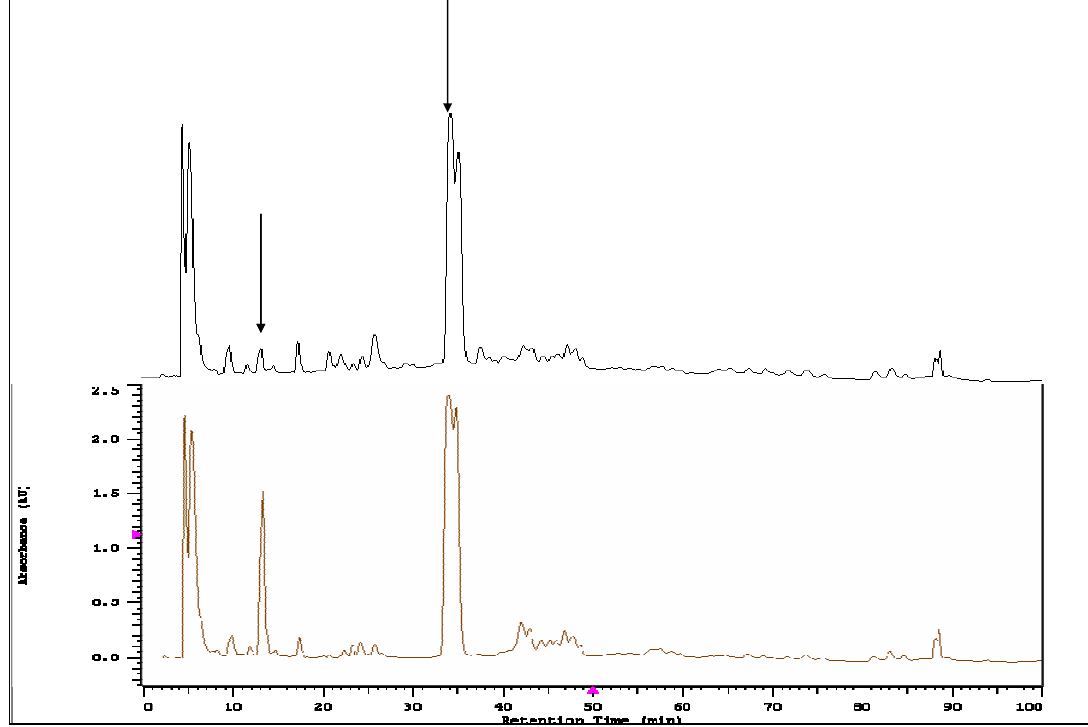
Figure 4. Of the 27 plant extracts that were screened, only the extract from Koelreuteria henryi exhibited strong xanthine oxidase, tyrosinase, and lipoxygenase inhibitory activity thus indicating this extract was an appropriate candidate for HPLC-DAD analysis. Upper line: HPLC-DAD chromatogram of Koelreuteria henryi extract with tyrosinase. Lower line: HPLC-DAD chromatogram of Koelreuteria henryi extract without